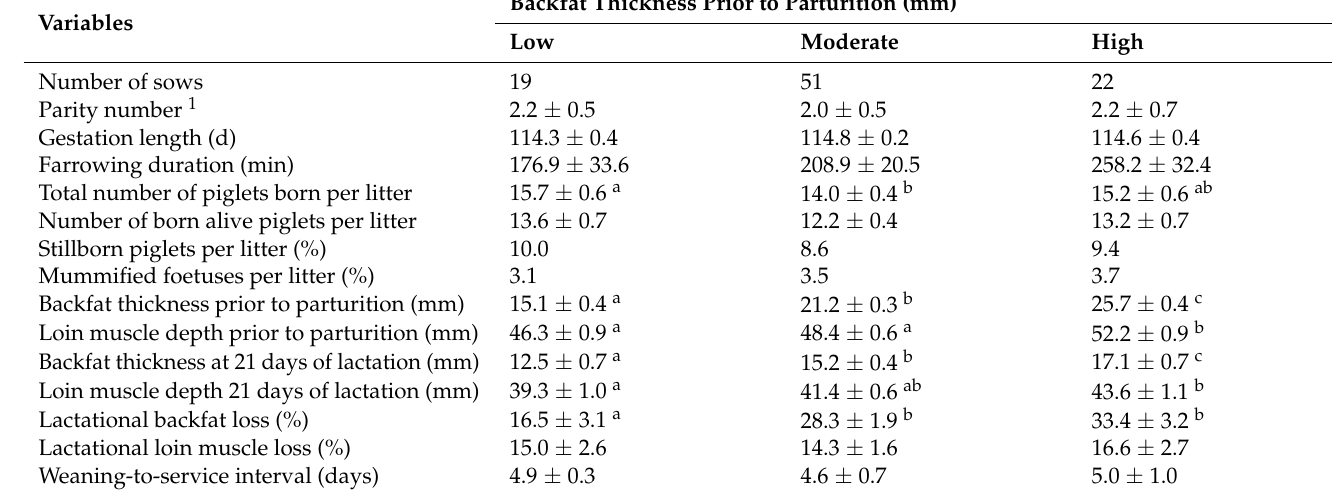
Table 2. Gestation length, litter traits and metabolic parameters of sows with low (<18 mm), moderate (18 to 24 mm) and high (>24 mm) backfat thickness prior to parturition (Lsmeans ±